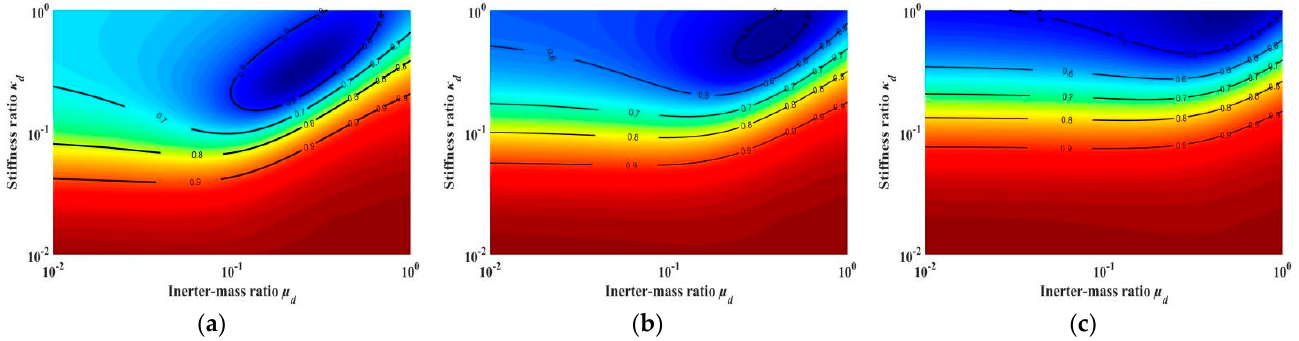
Figure 11. 2D Contour plot of γ Ur of HC system: ( a ) ζ d = 0.05; ( b ) ζ d = 0.10; and ( c ) ζ d = 0.15.